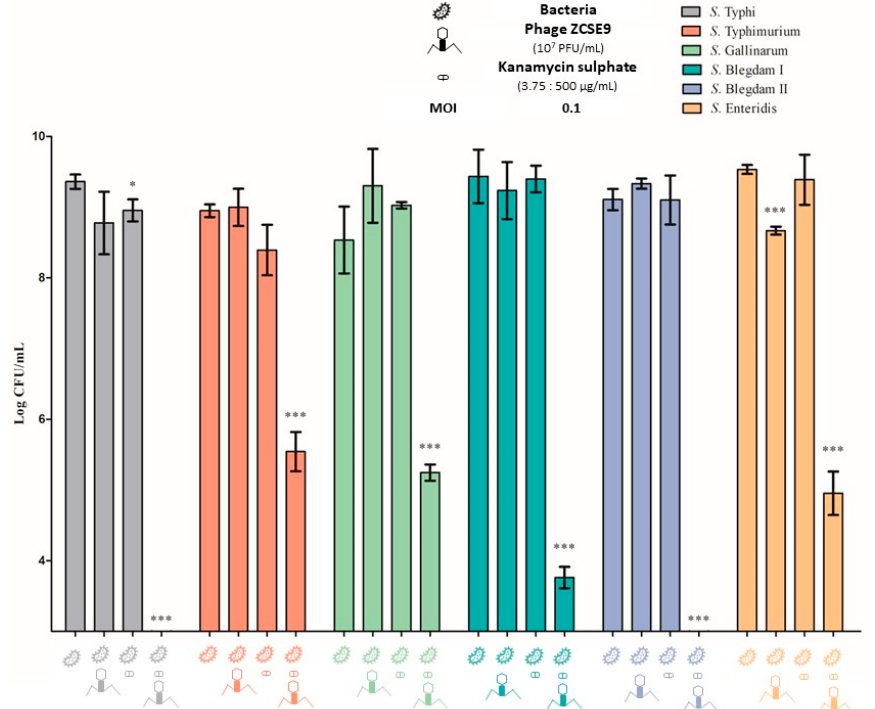
Figure 8. Overnight phage ZCSE9–kanamycin synergy quantification against S. Typhi (NCTC 160), S. Typhimurium (NCTC 13348), S. Gallinarum (CMPZC49G.B), S. Blegdam I (CMPZC53 sple), S. Blegdam II (CMPZC52 int), and S. Enteritidis (CMPZC78 Sple) that was treated with kanamycin concentrations of 7.5, 7.5, 15, 15, 15, and 15 µ g/mL, respectively. The ZCSE9 in this experiment was at an MOI of